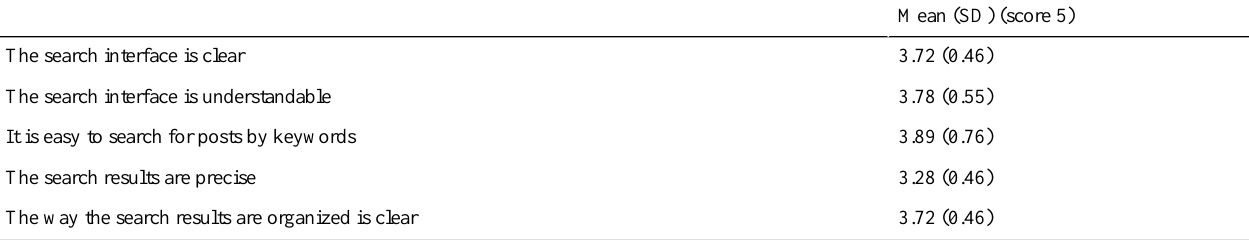
Table 7. Results of the search functionality evaluation.